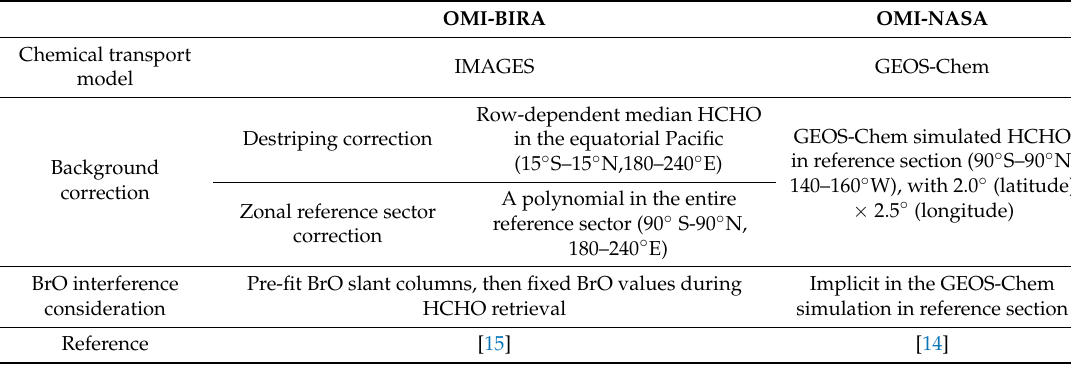
Table 2. OMI-BIRA and OMI-NASA algorithm setting